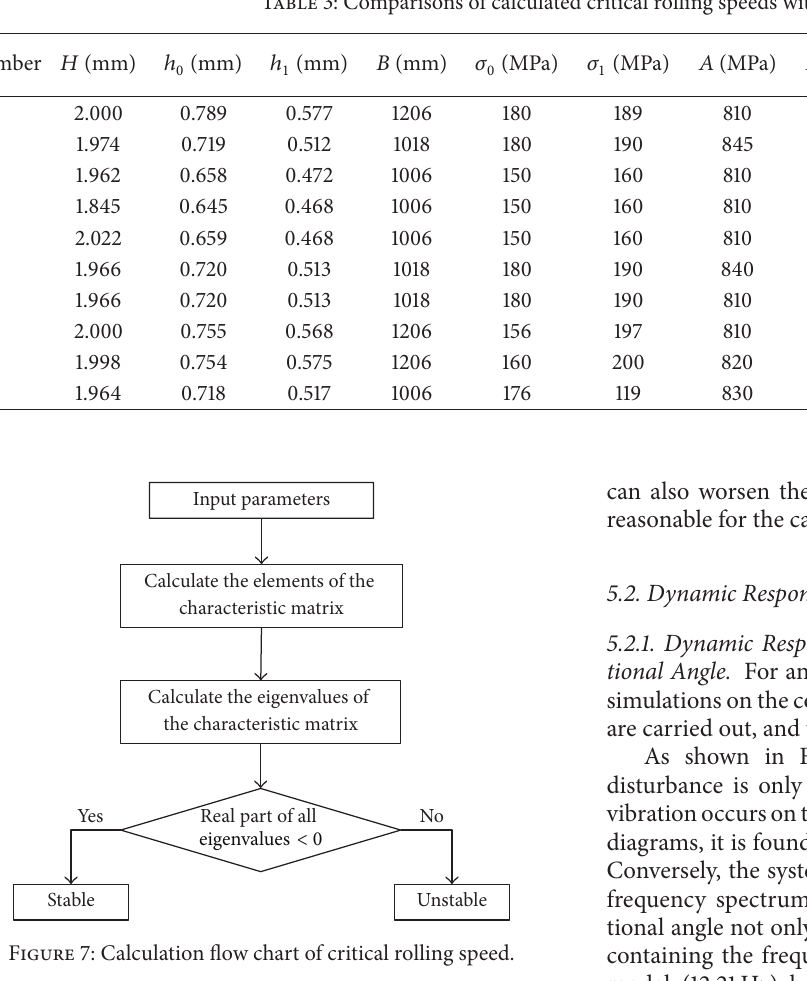
Table 3: Comparisons of calculated critical rolling speeds with test data.